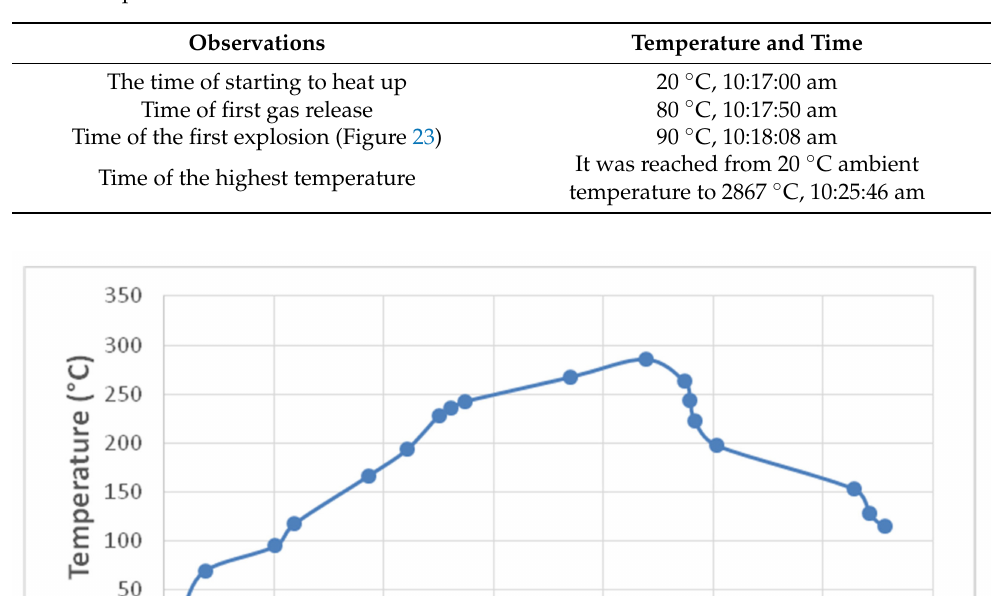
Figure 23. Explosion image during Exp. B.1. Table 4. Exp. B.1 results.